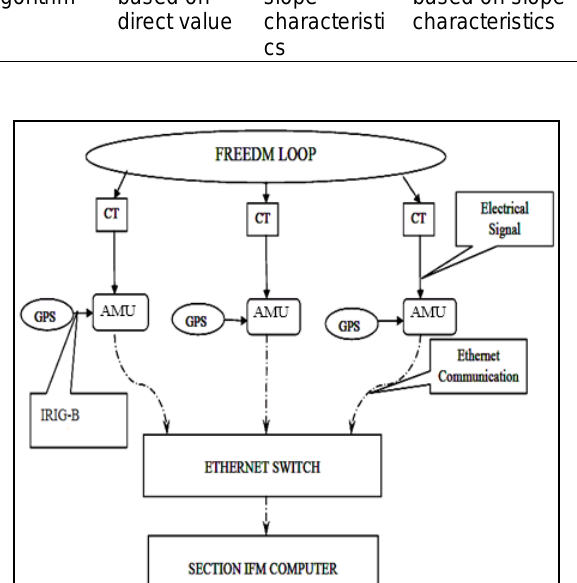
Figure 3. The data acquisition in the